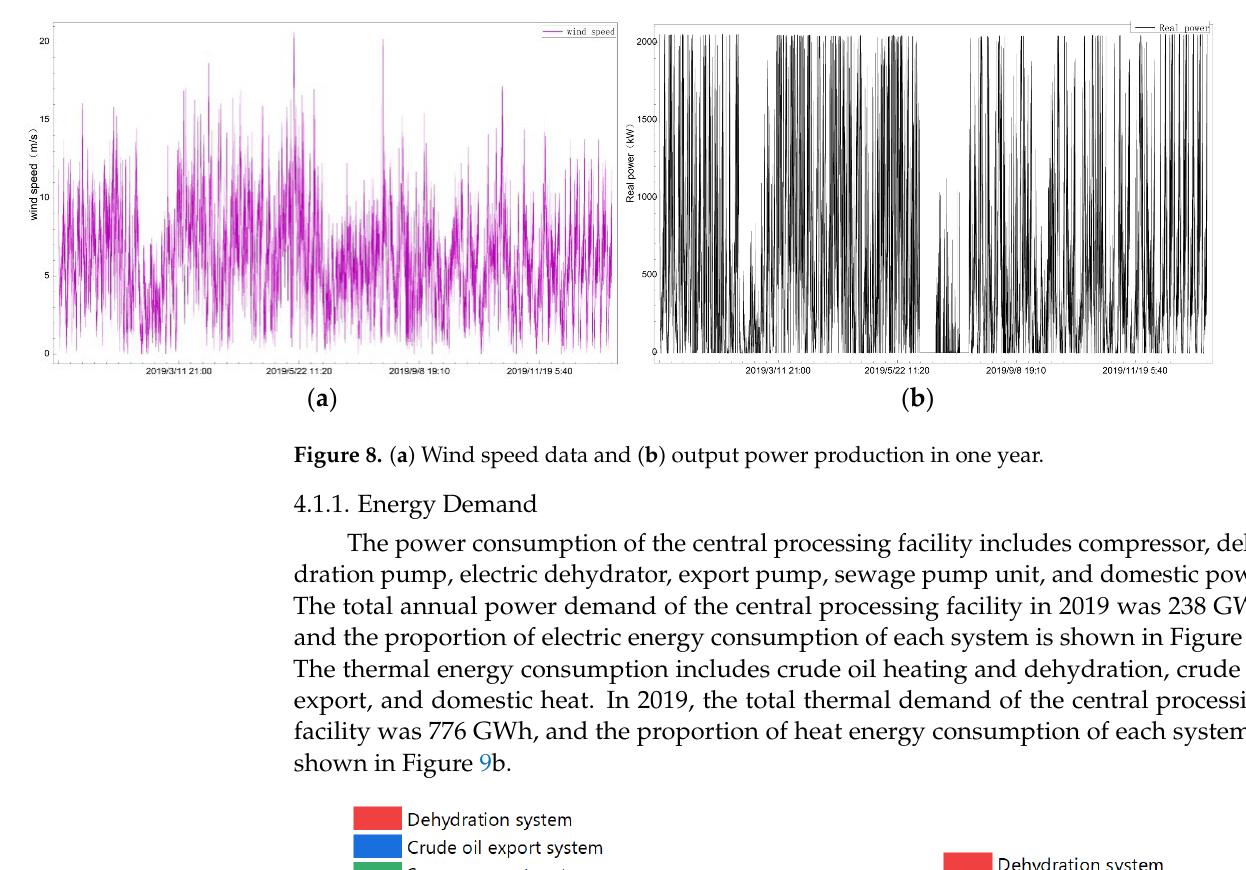
Figure 7. The geographic locations of an oilfield in China.